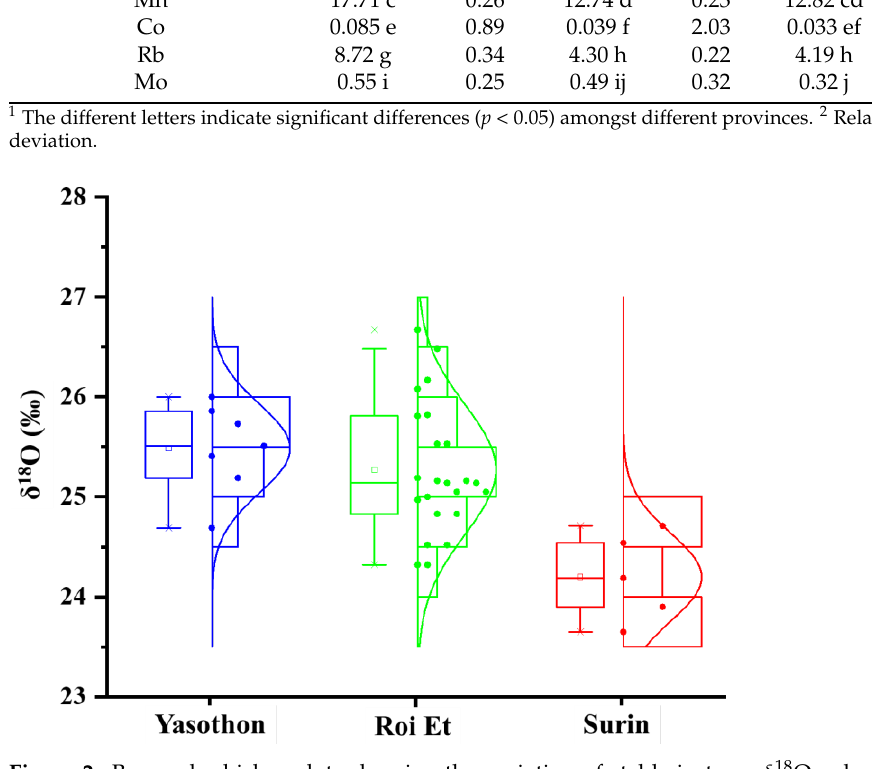
Figure 2. Box-and-whisker plots showing the variation of stable isotope, δ 18 O values in THMR collected from three contiguous provinces in Thailand covering YP (n = 7), RP (n = 16), and SP (n = 5), respectively.